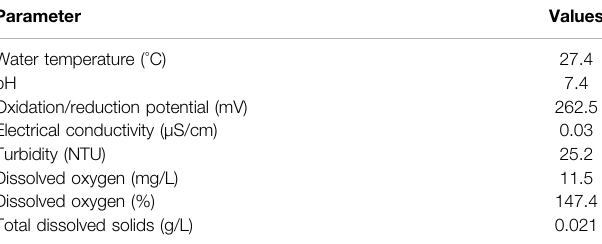
TABLE 2 | Limnological characterization of the water in the UFJF Botanical Garden lake. Parameter